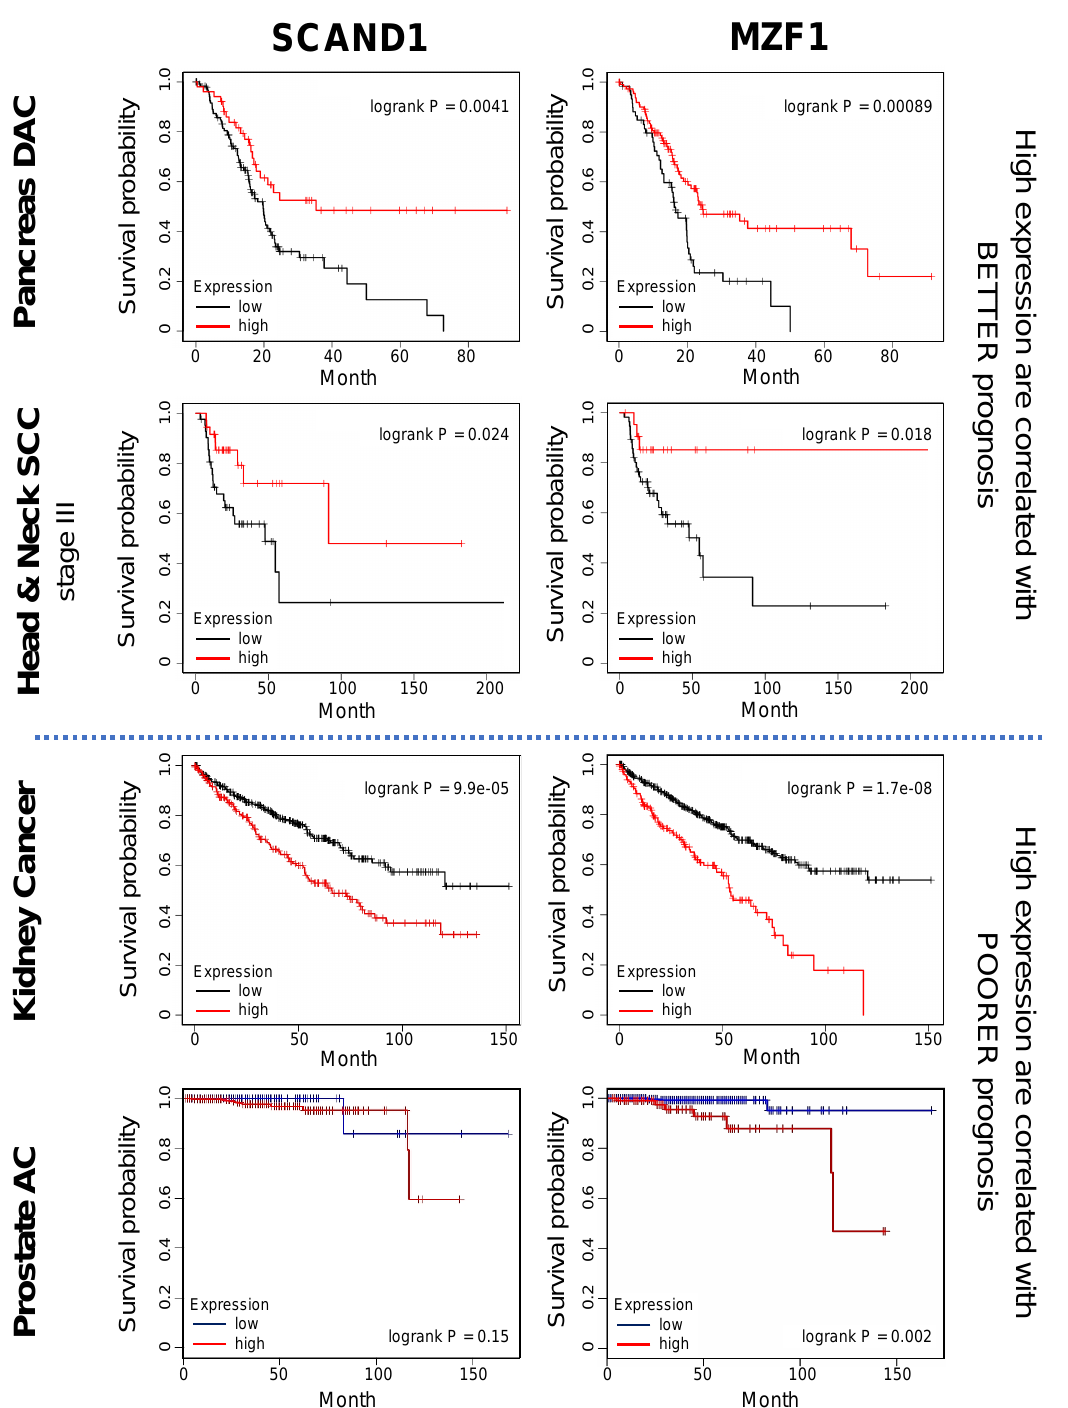
Figure 6. Prognostic values of SCAND1 and MZF1 expression in cancer patients. Kaplan–Meier plotting was performed to compare the prognosis of high- vs. low-expression groups of SCAND1 and MZF1 in patients suffering from pancreas cancer, head and neck cancer, kidney cancer (RCC), and prostate